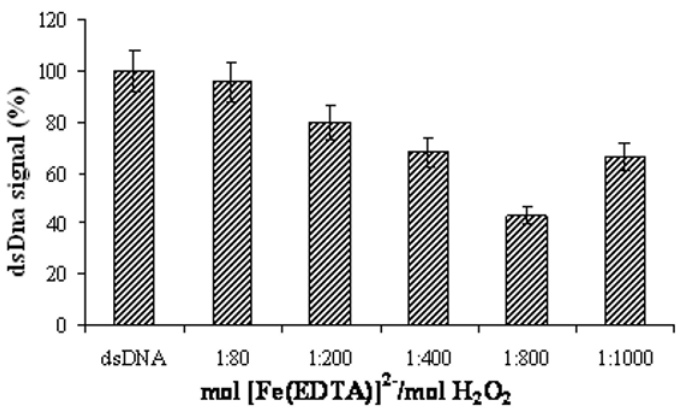
) on the oxidative signal of guanine base. dsDNA